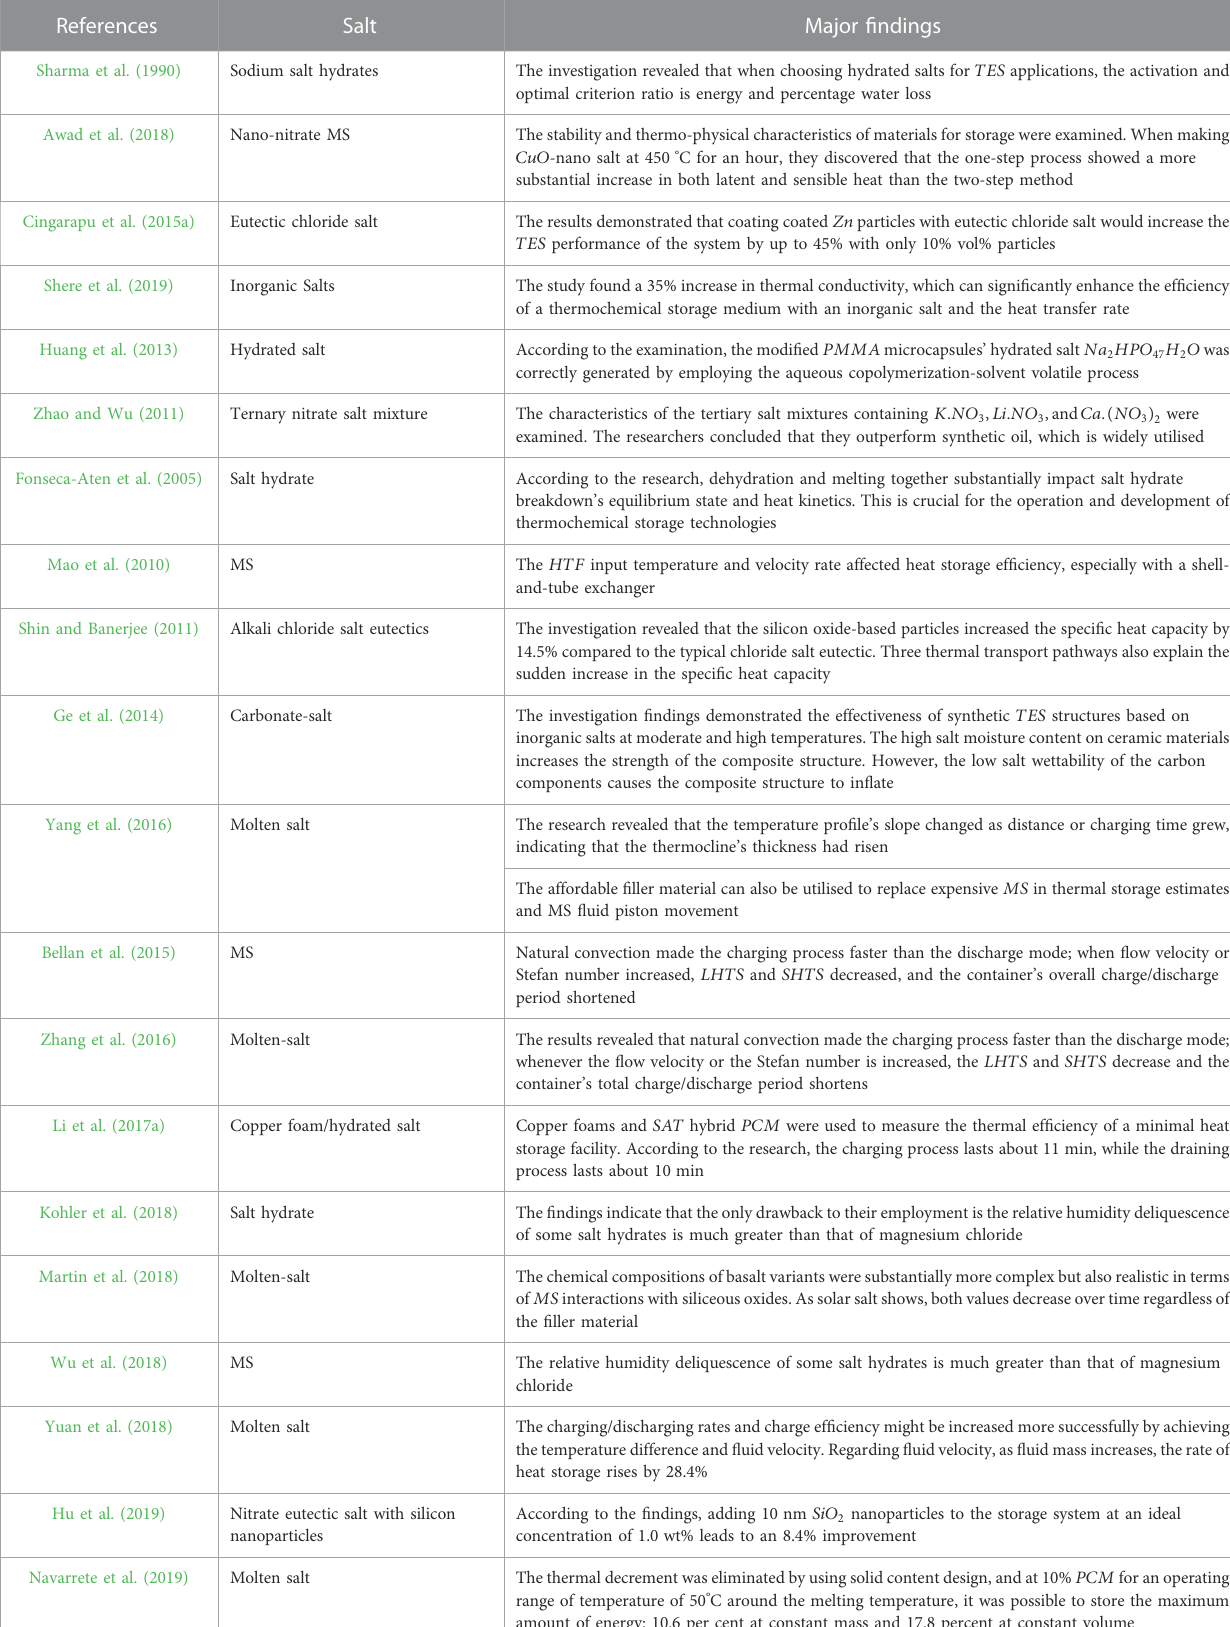
TABLE 1 Previous experimental analysis of the TES system with various salt as storage